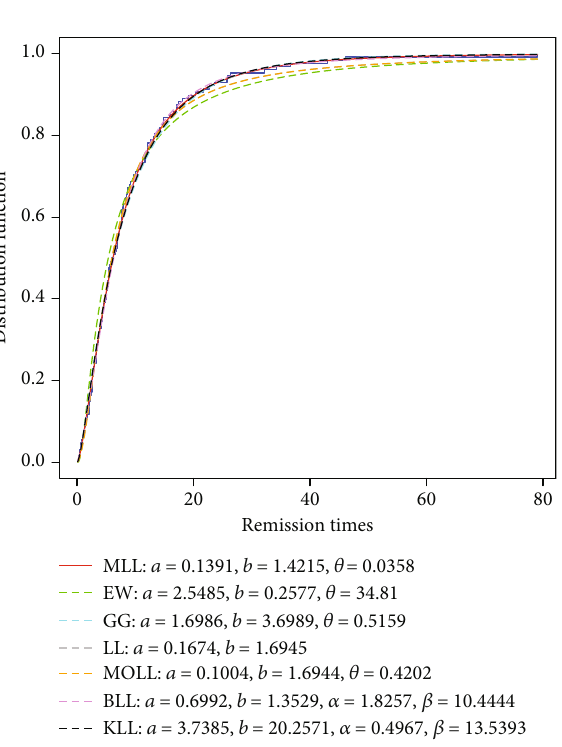
Figure 5: The empirical distribution function of remission times along with estimated